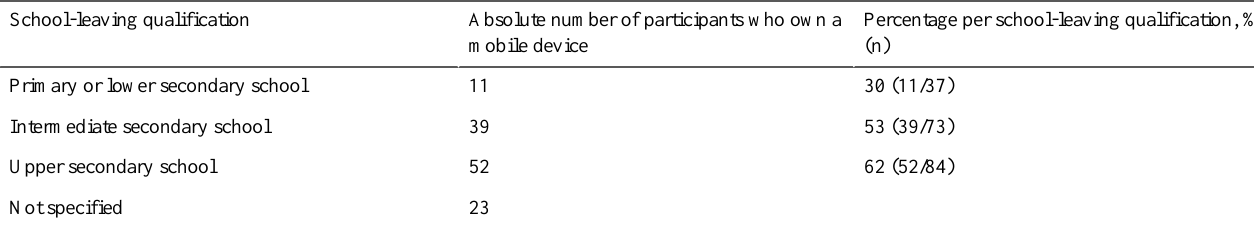
Table 3. Ownership of a mobile device versus educational level.